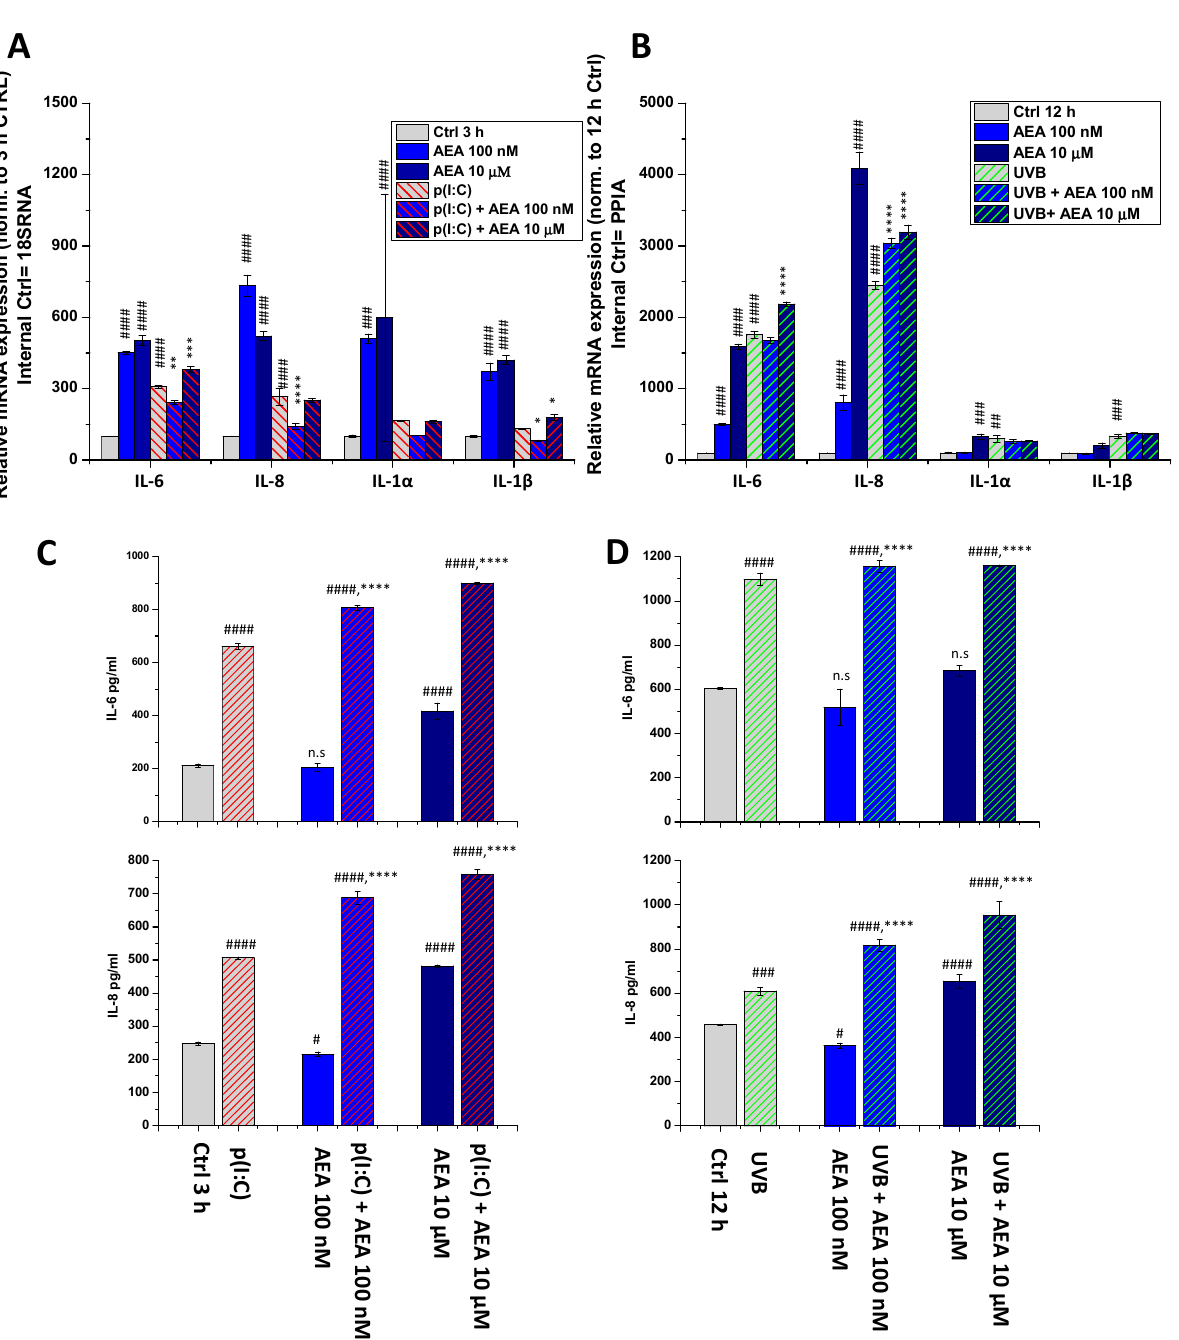
Figure 4. AEA exerts concentration-dependent effects on the inflammatory cytokine expression and release of human corneal epithelial cells: ( A , B ) Q-PCR IL-6, IL-8, IL-1 α , and IL-1 β mRNA expression was determined following 3 h p(I:C) treatment ( A ) and 12 h after 40 mJ/cm 2 UVB irradiation ( B ). Data are presented using the ∆∆ CT method compared to 18SRNA ( A ) and PPIA ( B ), normalized to the expression of the vehicle-treated control (shown as 100). Data are expressed as mean ± SD of 2–3 determinations. One additional experiment yielded similar results. *, **, ***, **** mark significant ( p < 0.05, 0.01, 0.001, 0.0001) differences compared with the UVB- or the p(I:C)-treated group; #, ##, ###, #### mark significant ( p < 0.05, 0.01, 0.001, 0.0001) differences compared to the vehicle-treated control. ( C , D ) ELISA determination of IL-6 and IL-8 in the supernatant of human corneal epithelial cells following 3 h p(I:C) and 12 h after UVB irradiation. Data are expressed as mean ± SD of three determinations. One additional experiment yielded similar results. *, **, ***, **** mark significant ( p < 0.05, 0.01, 0.001, 0.0001, respectively) changes compared to the treated group; #, ##, ###, #### significant ( p < 0.05, 0.01, 0.001, 0.0001) differences compared to the control.